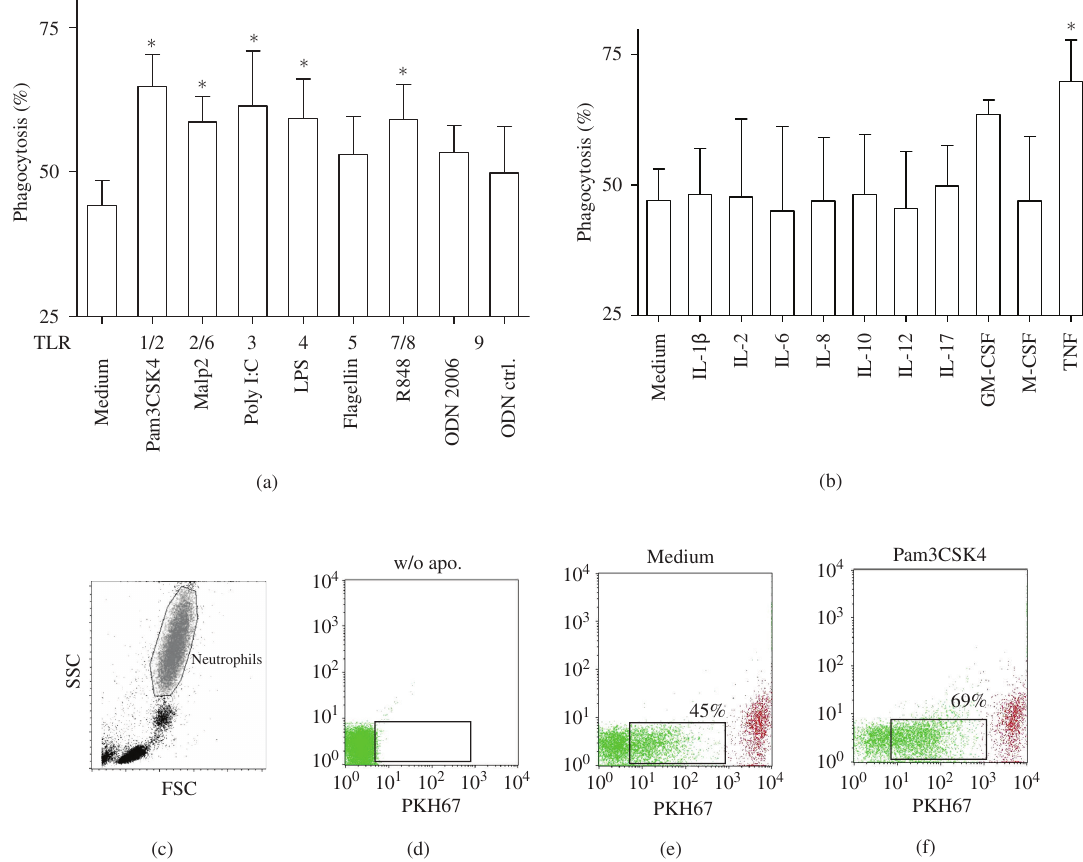
FIGURE 2: Phagocytosis of apoptotic neutrophils by neutrophils in whole blood. 50 μ L heparinized whole blood was preincubated with the indicated stimuli for 30 min and, subsequently, 1 × 10 6 PKH67 stained apoptotic neutrophils were added. Phagocytosis was assessed after 60 min by using flow cytometry. (a) Effect of TLR-ligands on the phagocytosis rate. (b) Effect of various cytokines on the phagocytosis rate. Data show mean + SD from 3 independent experiments, ∗ : P < 0 . 05 . (c)–(f) Representative dot-plots for the quantitative assessment of ingestion of apoptotic cells by neutrophils in whole blood by using flow cytometry. (c) FSC/SSC gating of neutrophils. (d) Negative control: gated neutrophils without apoptotic cells. (e) neutrophil phagocytosis of PKH67-labeled (green) apoptotic neutrophils. (f) Neutrophil phagocytosis of PKH67-labeled (green) apoptotic neutrophils after exposure to